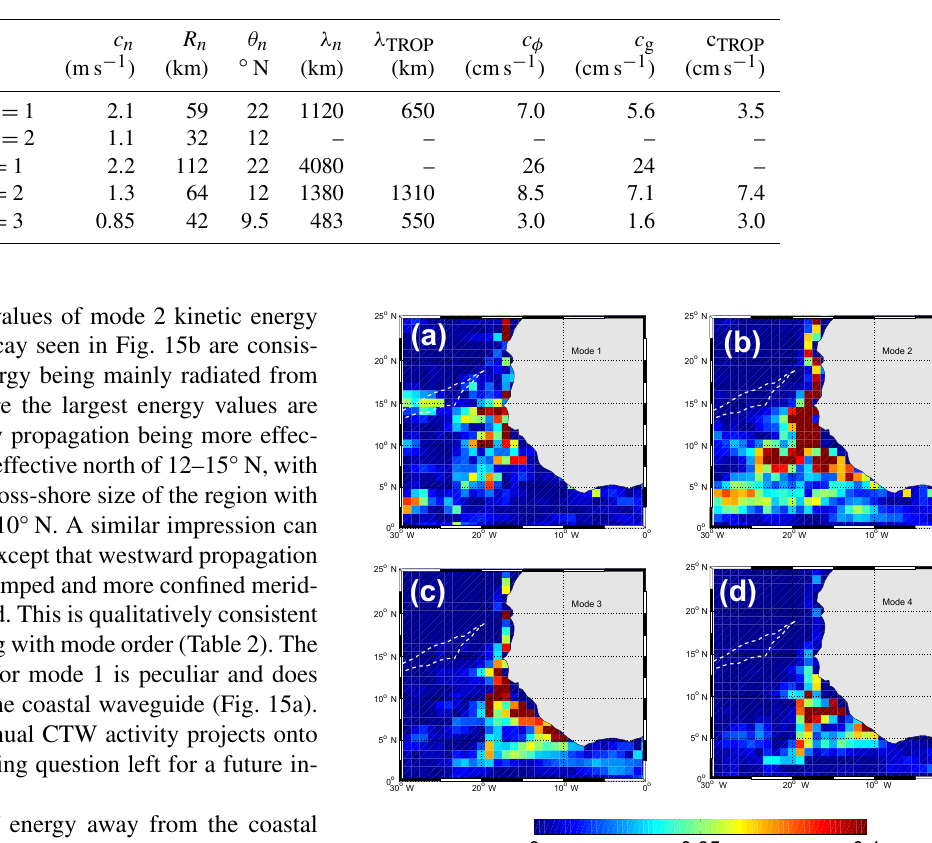
Table 2. Parameters associated with each potential semiannual RW mode at 8 (baroclinic mode 1 to 3) and 14 ◦ N (baroclinic mode 1 and 2). Gravity phase speed (ms − 1 ), deformation radius (km), critical latitude (km), theoretical wavelength (km), observed TROP025 wavelength (km), theoretical phase speed (cms − 1 ), theoretical group velocity (cms − 1 ), and observed TROP025 propagation speed (cms − 1 ) are reported. No mode 1 RW is identified at 8 ◦ N. A mode 2 RW is also not identified at 14 ◦ N, in agreement with linear theory predicting its evanescence. Note the important discrepancies between theory and model RW mode 1 at 14 ◦ N.